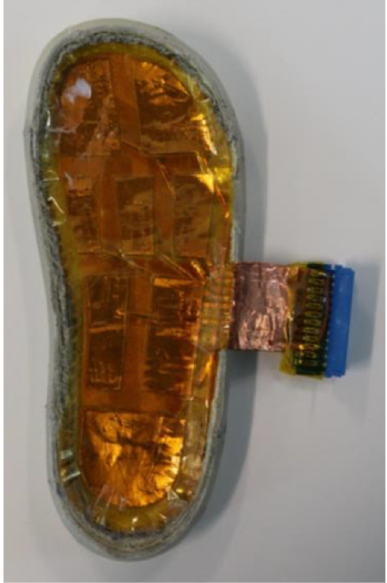
Figure 6. Assembled sensor installed on the outsole.